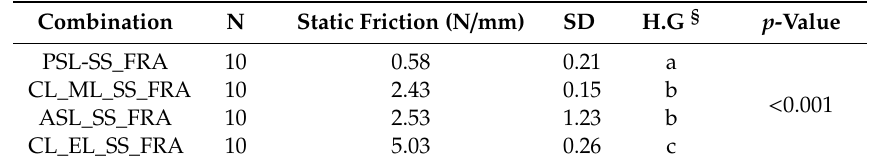
Table 7. Static friction values using rectangular section stainless steel wire and a friction reducer agent (SS_FRA). The letters show significance statistical di ff erences.